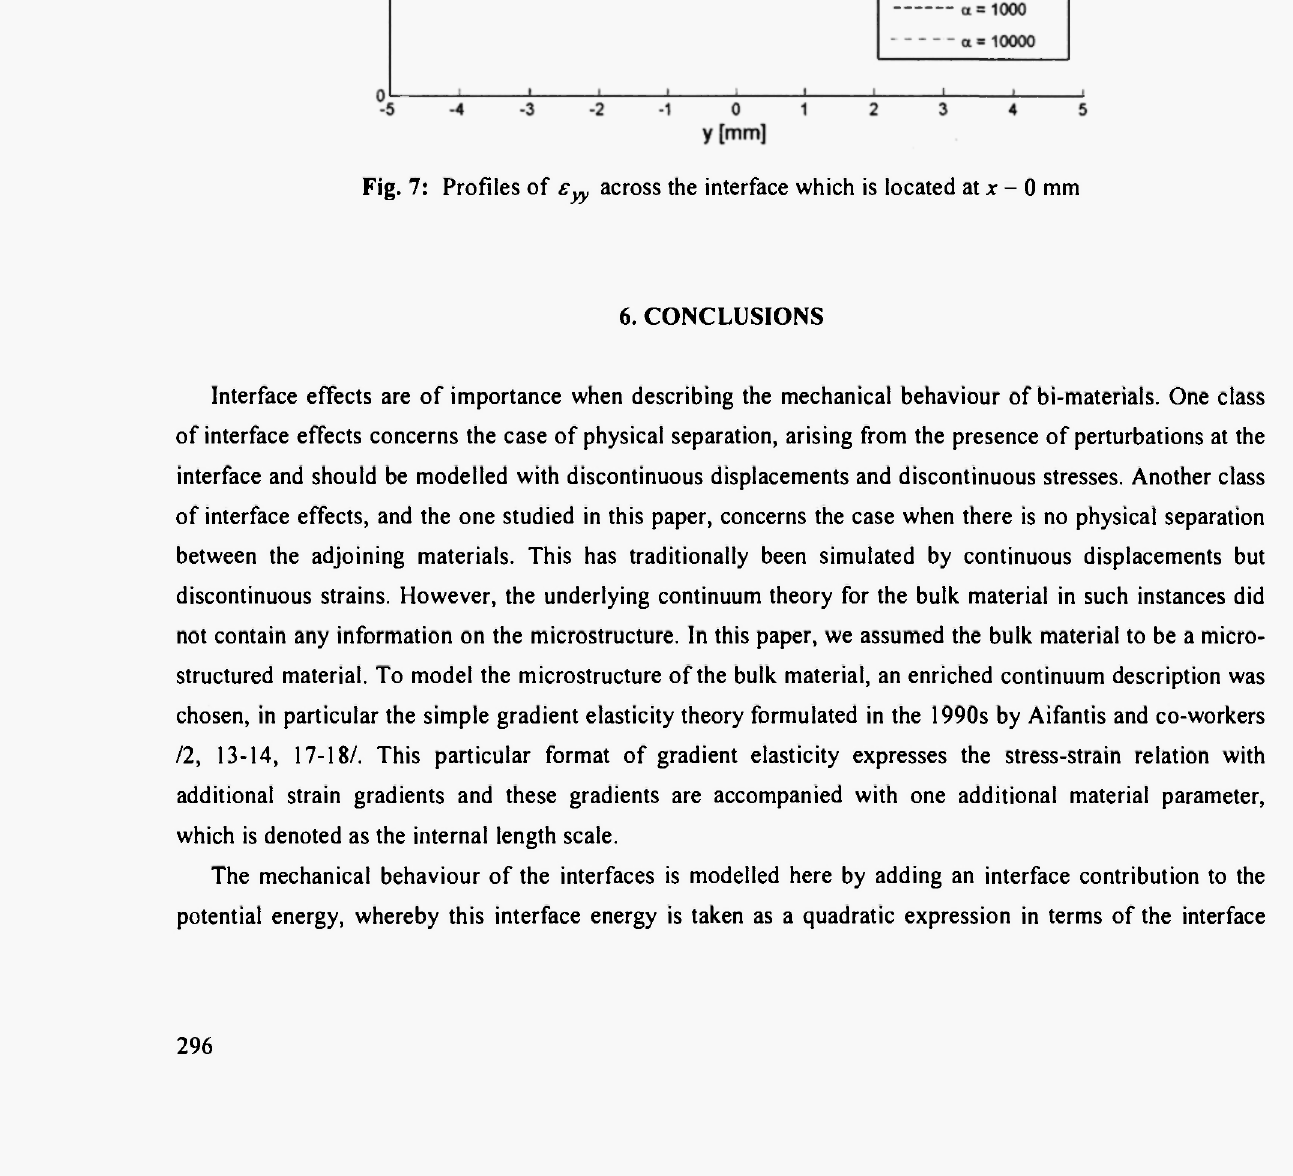
Fig. 7: Profiles of ε w across the interface which is located at χ - 0